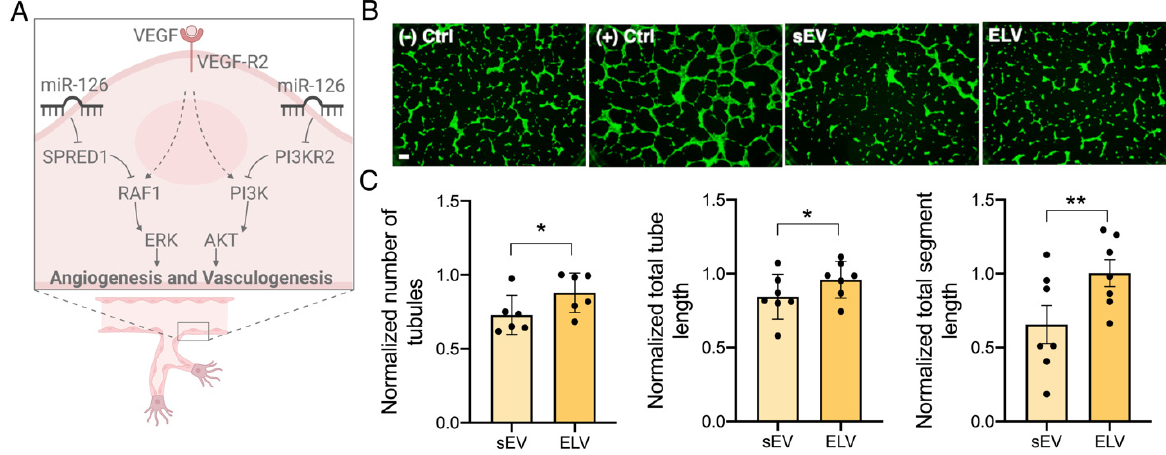
Figure 5. miR-126+ ELVs induce pro-angiogenic response in CECs. ( A ) Schematic of miR-126 mechanism of action for angiogenesis. VEGF: vascular endothelial growth factor; RAF1: rapidly accelerated fibrosarcoma proto-oncogene; ERK: extracellular signal-regulated kinase; AKT: protein kinase B; PI3K: Phosphoinositide 3-Kinase. ( B ) CECs (green) treated with miR-126+ ELVs or sEVs incubated on Matrigel form tubes after overnight incubation. CECs treated with calcein-AM. Scale bar = 200 µ m. ( C ) Quantification of angiogenic parameters (ImageJ software version 2.1.0/1.53 g) shows increase in number of tubules, total tube length and segment length for CECs treated with miR-126+ ELVs compared to sEVs. Data normalized to negative control. n = 6–7 represent biological replicates. Mean ± SEM. Significance was tested with two-way Student’s paired t -test. * p ≤ 0.05, ** p ≤